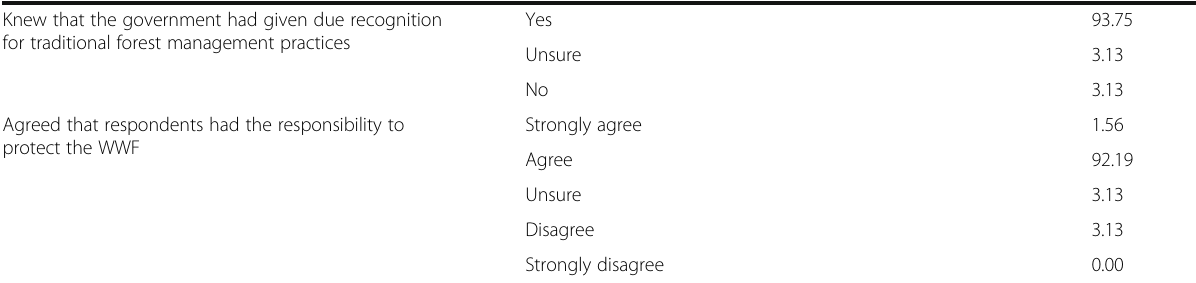
Table 2 Socio-economic characteristics and descriptive results